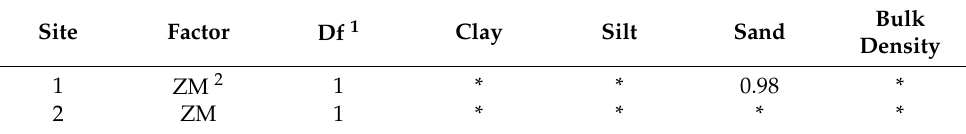
Table 7. Results of the ANOVA applied to the soil samples based on the zone management experi- mental factor for both sites.